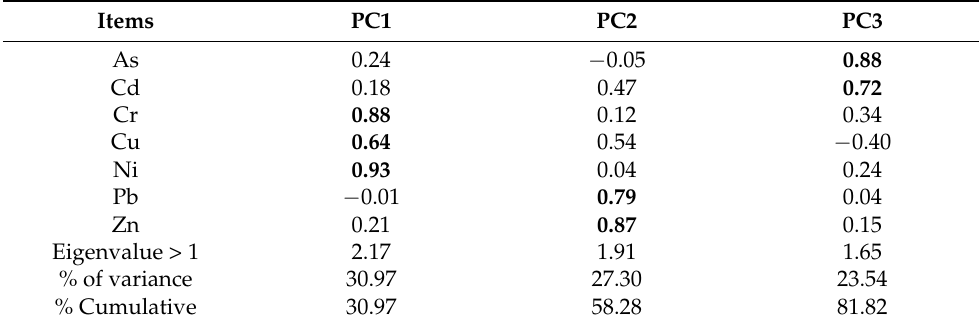
Table 3. Rotated component matrix for soil